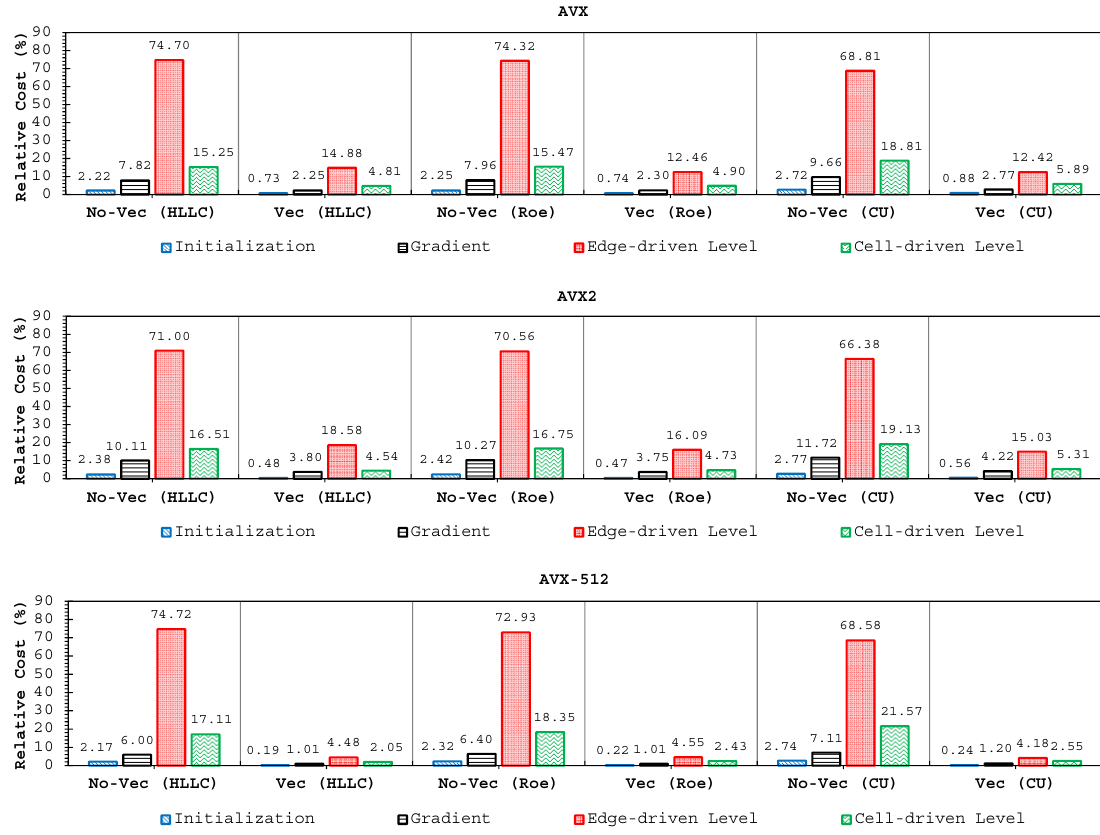
Figure 20. Components of the entire simulations for all